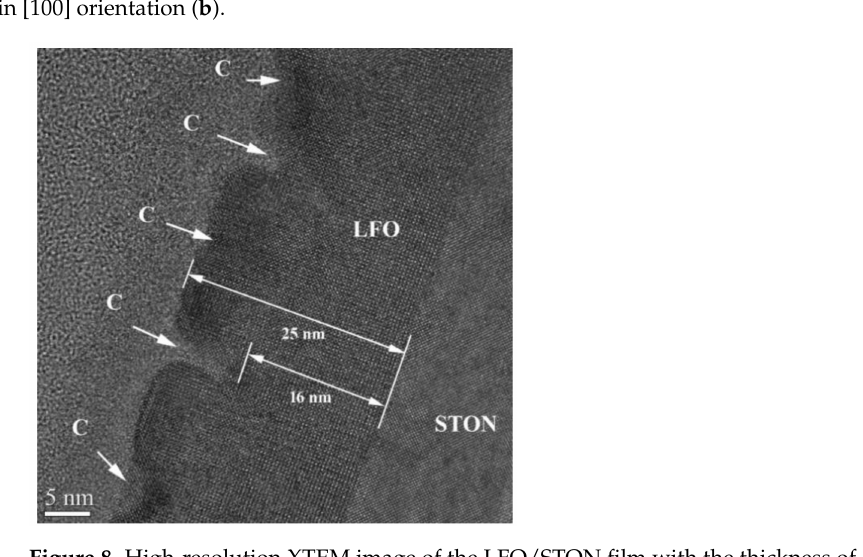
Figure 8. High-resolution XTEM image of the LFO/STON film with the thickness of about 25 nm in the [100] crystallographic